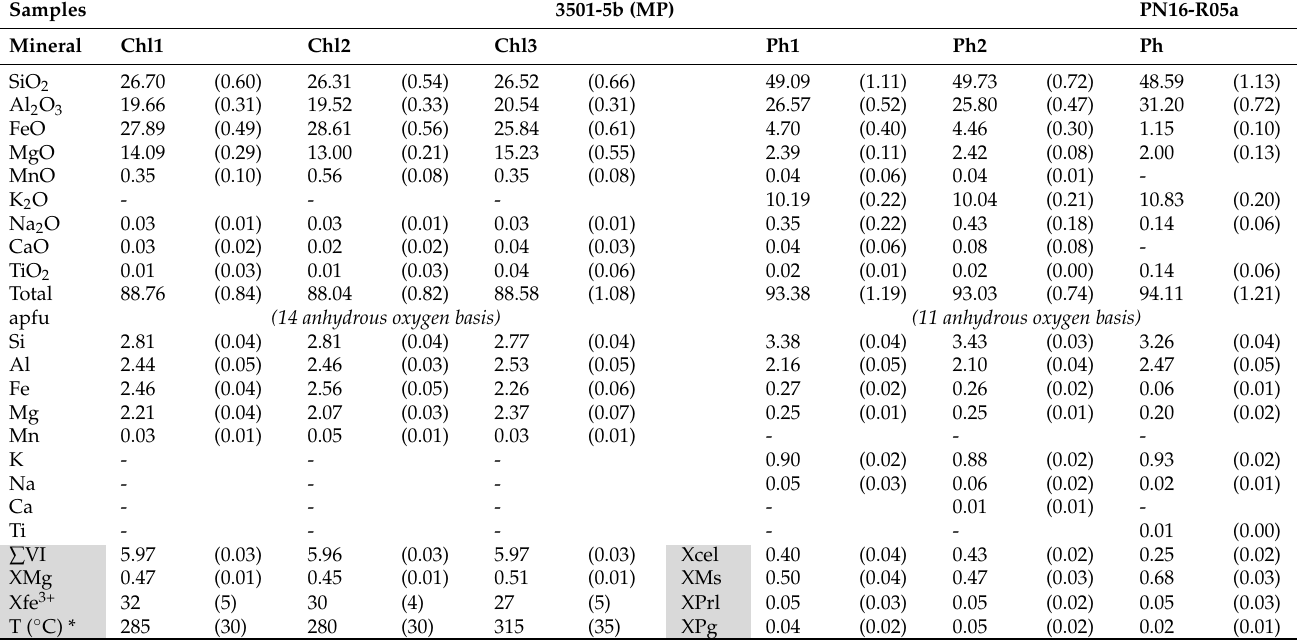
Table 2. Representative EPMA chlorite and phengite compositions for the MP and PN ores. Standard deviations ( σ ) are expressed within parentheses. Oxides are expressed in wt% and elementary atoms per formula unit (apfu). Sum VI corresponds to the octahedral